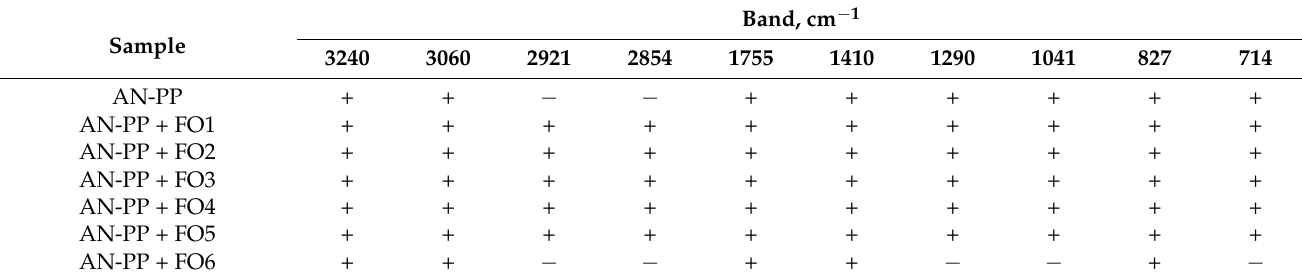
Table 3. The results of an IR analysis of AN-PP and non-ideal explosives obtained by mixing AN-PP with a FO: P1–P6.